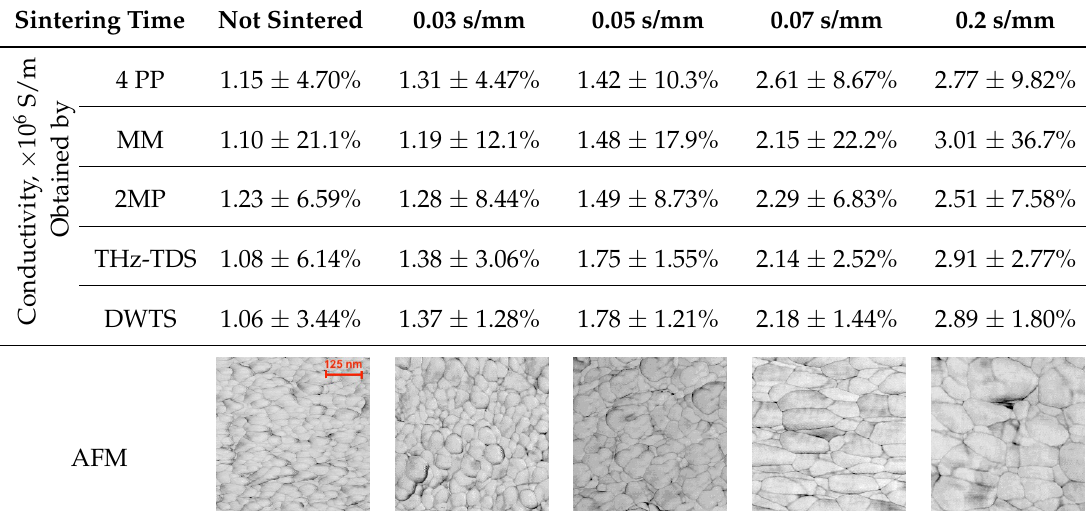
Table 1. Comparison between terahertz time-domain spectroscopy (THz-TDS) and conventional techniques. The scale of atomic force microscopy (AFM) images is the same for all figures. Sintering